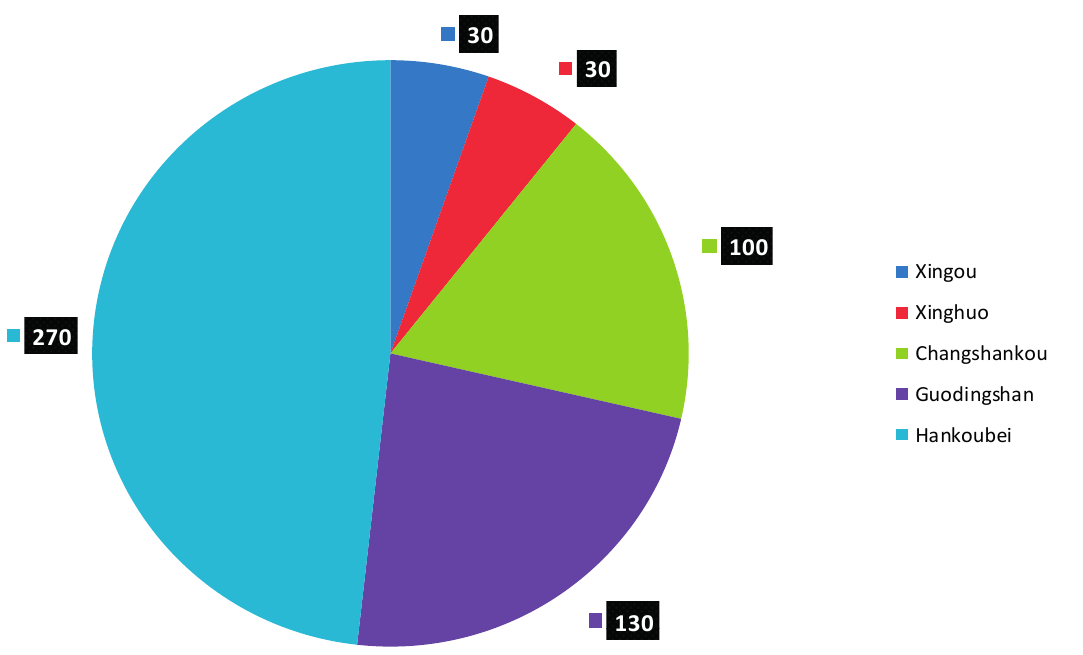
Figure 3. The output of fly ash in each incineration plant (metric ton/day).